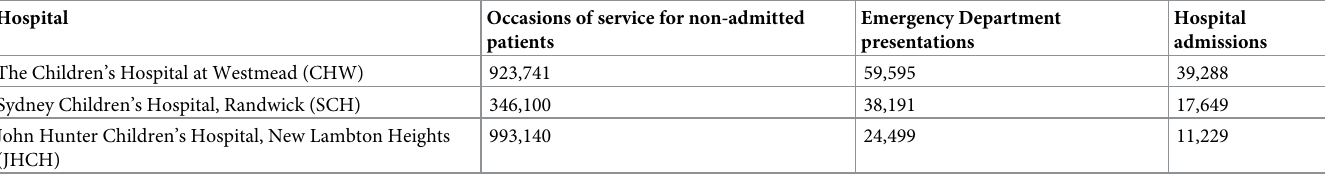
Table 1. All-cause case load for hospitals included in this study in